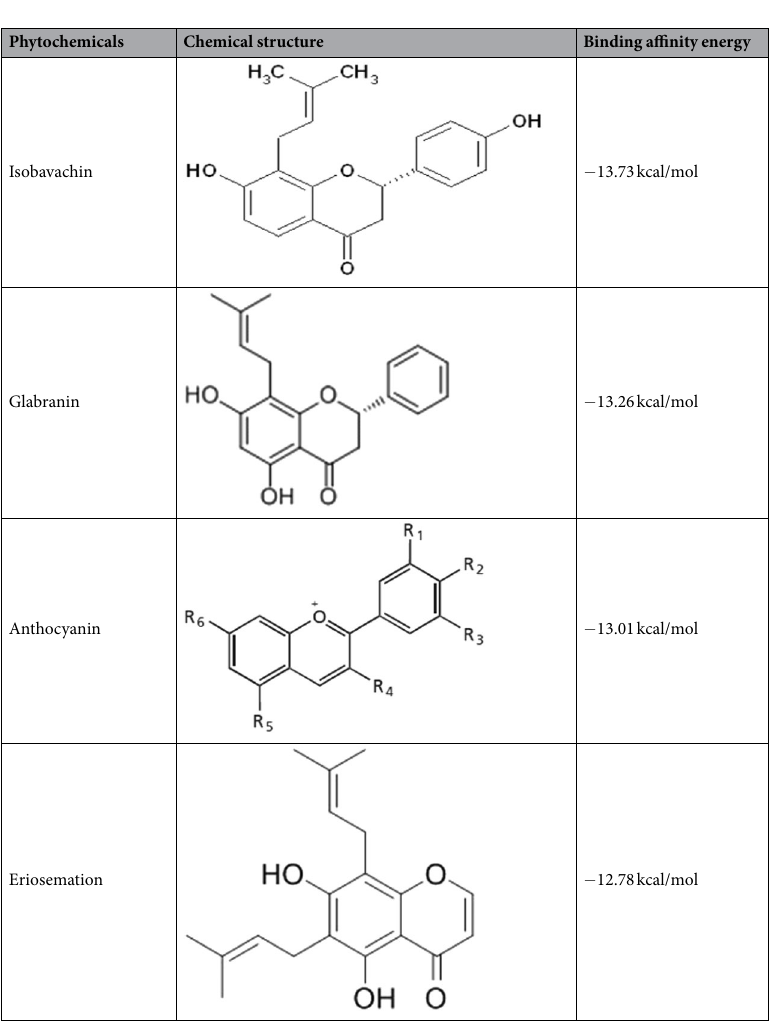
Table 3. Binding affinity energy of best docking pose of the shortlisted phytochemicals against